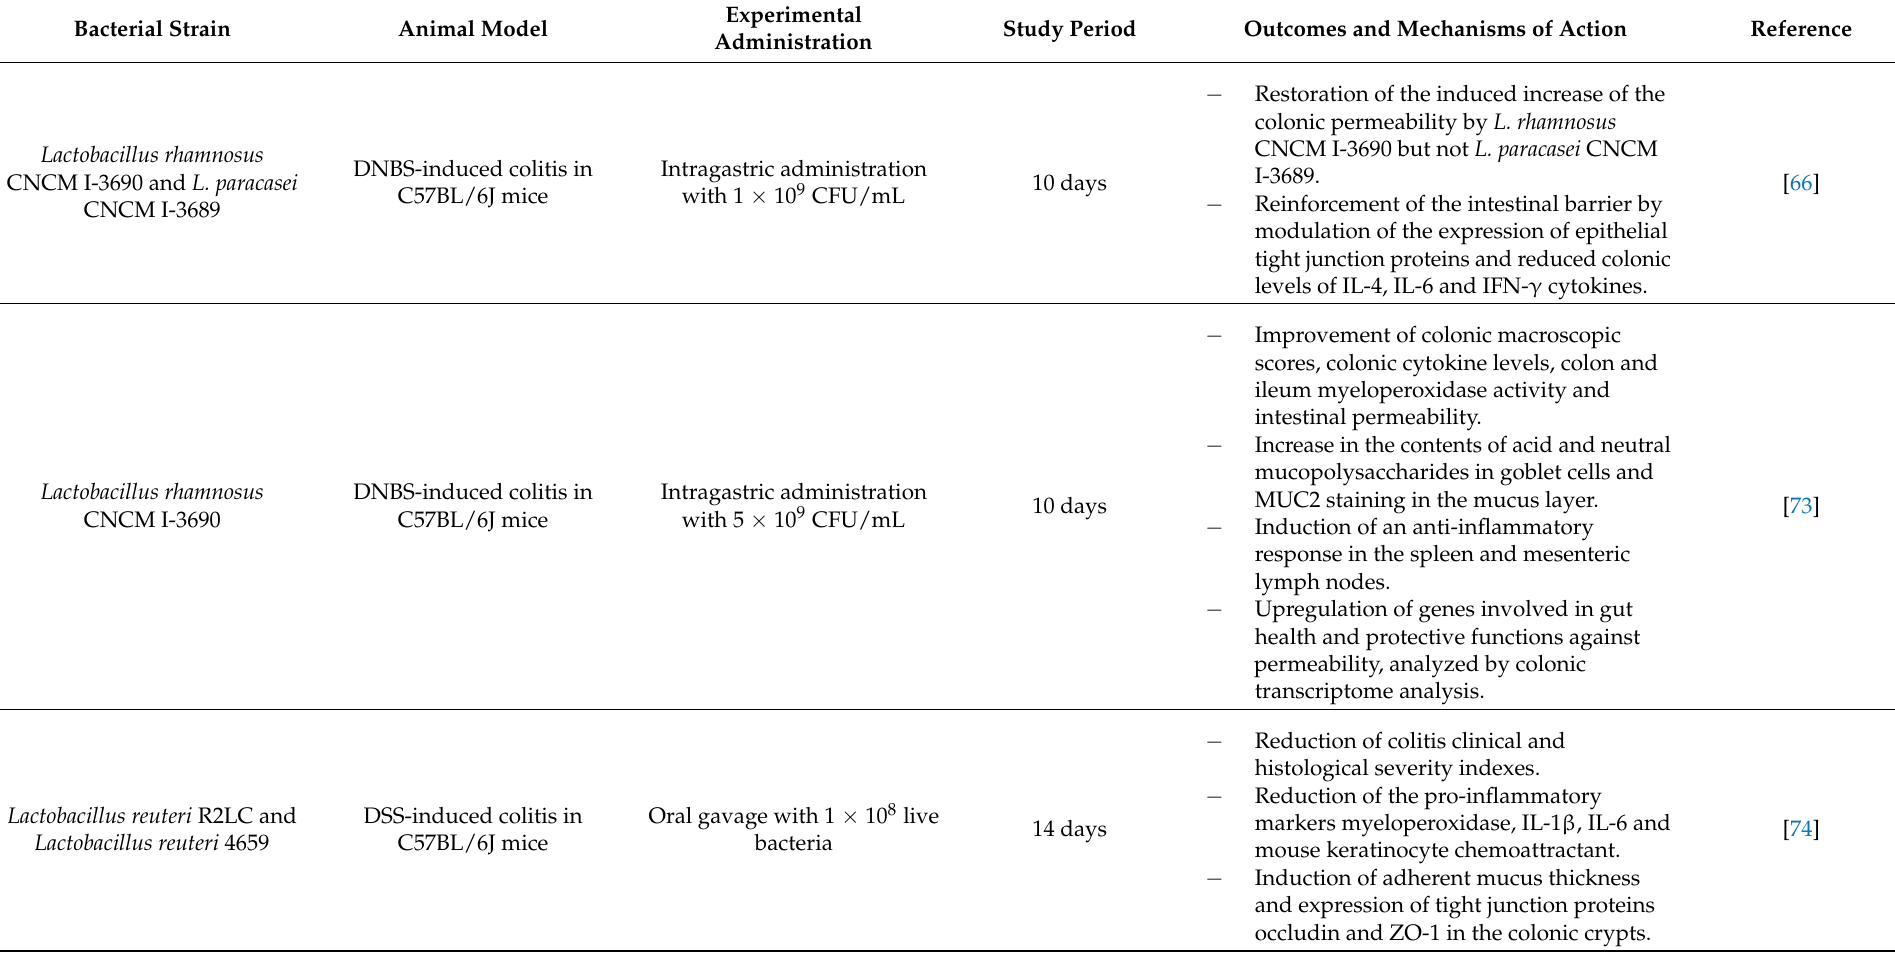
Table 1. Summary of studies evaluating in animal models the effects of gut bacterial species on the mucus